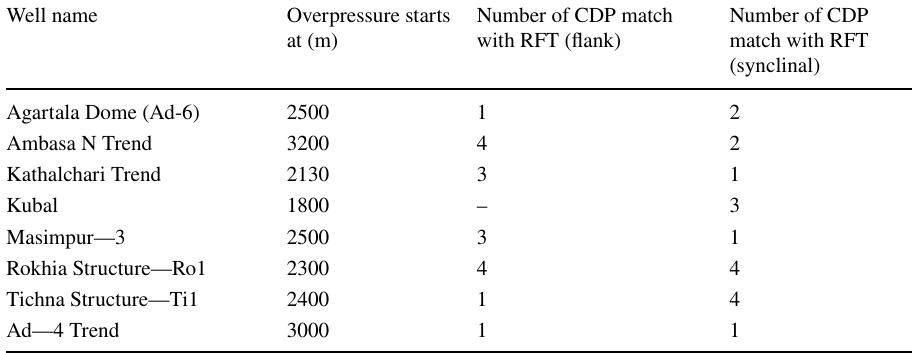
Well name Overpressure starts